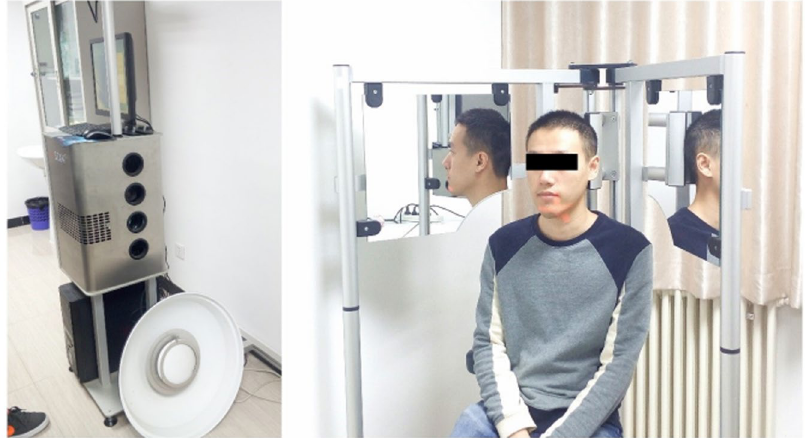
Figure 1. Facescan structured-light 3D scanner.